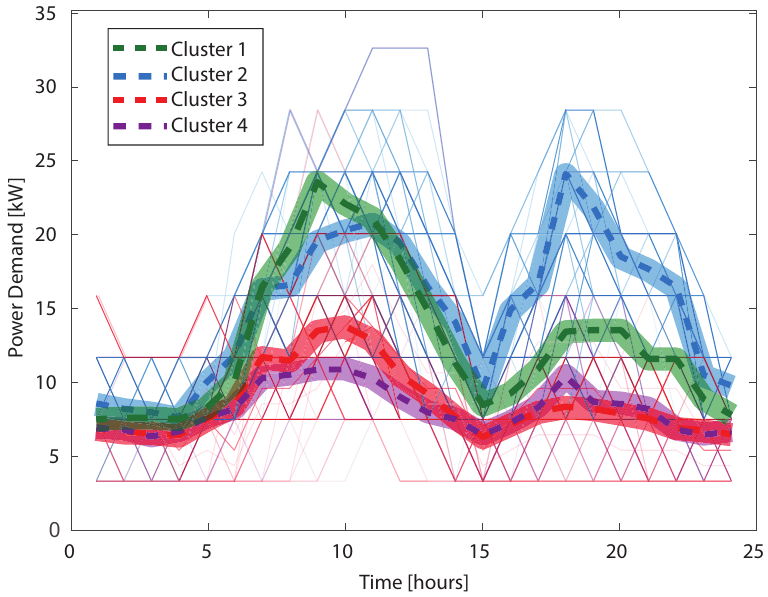
Figure 12. Cluster-Residential